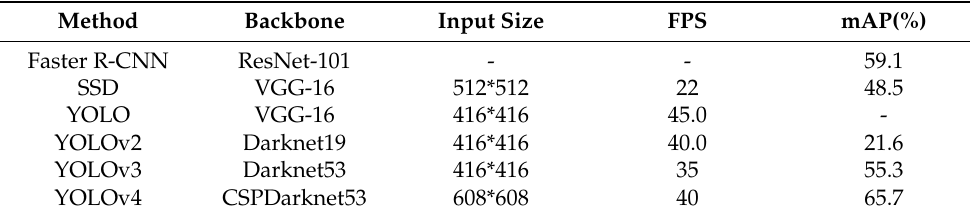
Table 2. Test results of different target detection algorithms on the COCO dataset.